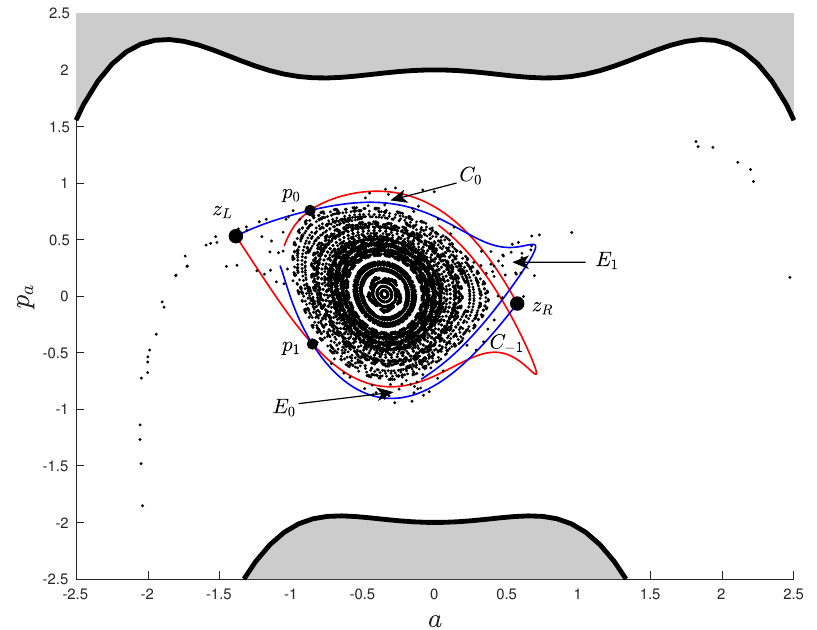
0.5. Two big black dots represent the unstable period Figure 7. Surface of Section for B = 1.5, E = − two orbit. The red line is the portion of the stable manifold, and the blue line is the portion of the unstable manifold. Thick black line defines the boundary between the energetically allowed (white) and forbidden (shaded)